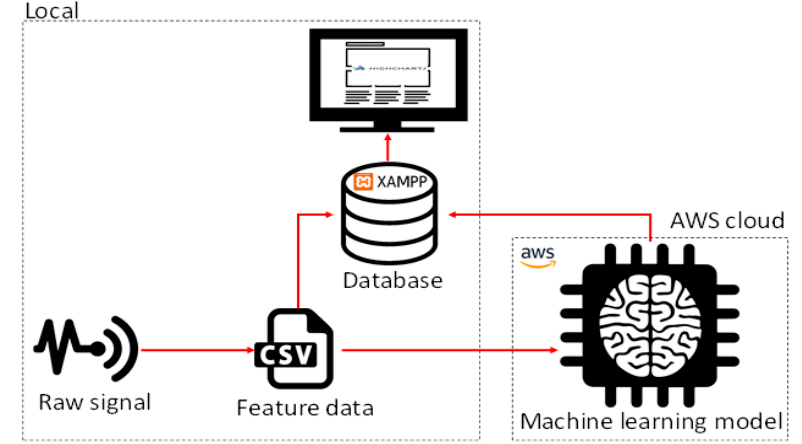
Figure 7. An overview of the monitoring system.